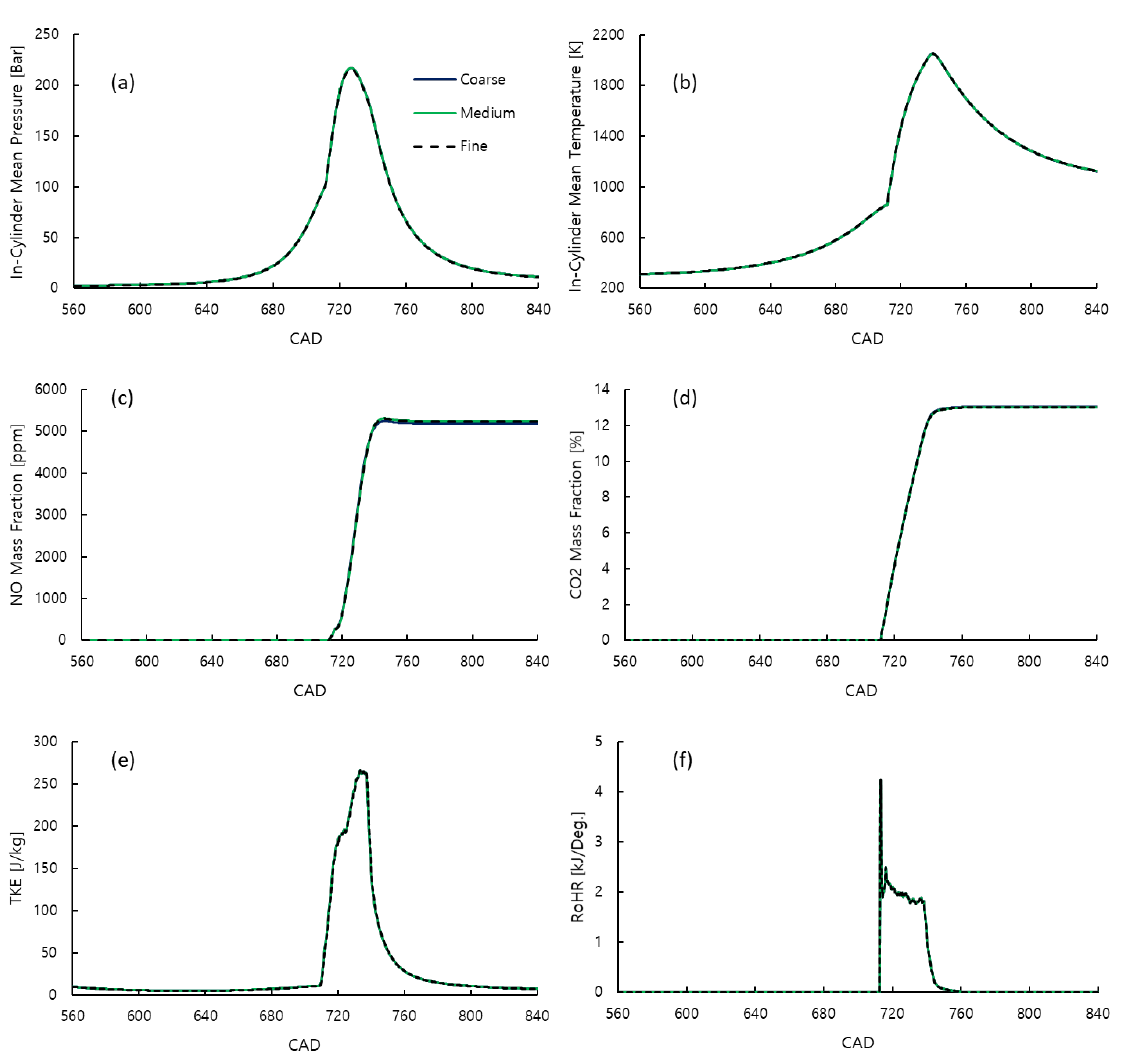
Figure 4. Results of the CFD simulations using the three various mesh resolutions: ( a ) in-Cylinder mean pressure, ( b ) in-Cylinder mean temperature, ( c ) NO mass fraction, ( d ) CO 2 mass fraction; ( e ) TKE, ( f ) RoHR.